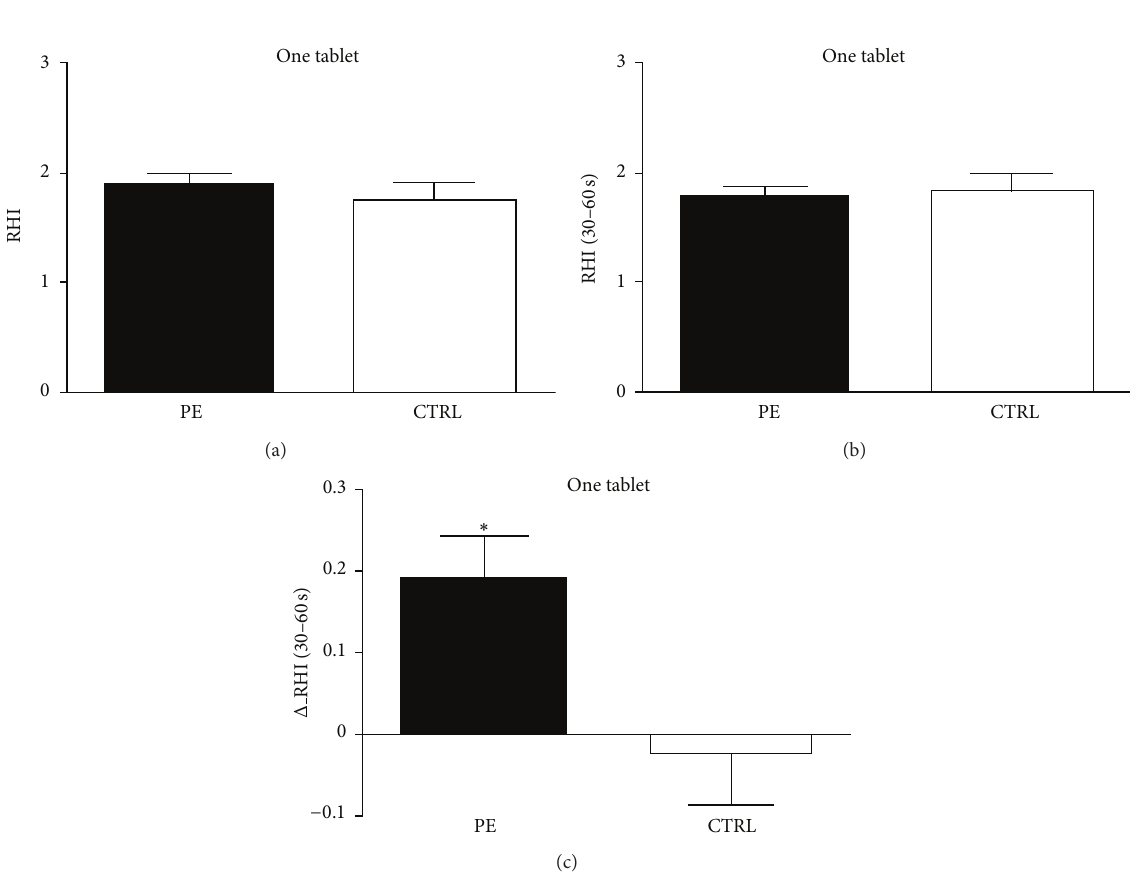
Figure 3: Variations in RHI values after assumption of one tablet of vardenafil 10mg. The difference between groups is significant only when calculated as a linear variation of increment from baseline (delta RHI). PE = premature ejaculation. CTRL =